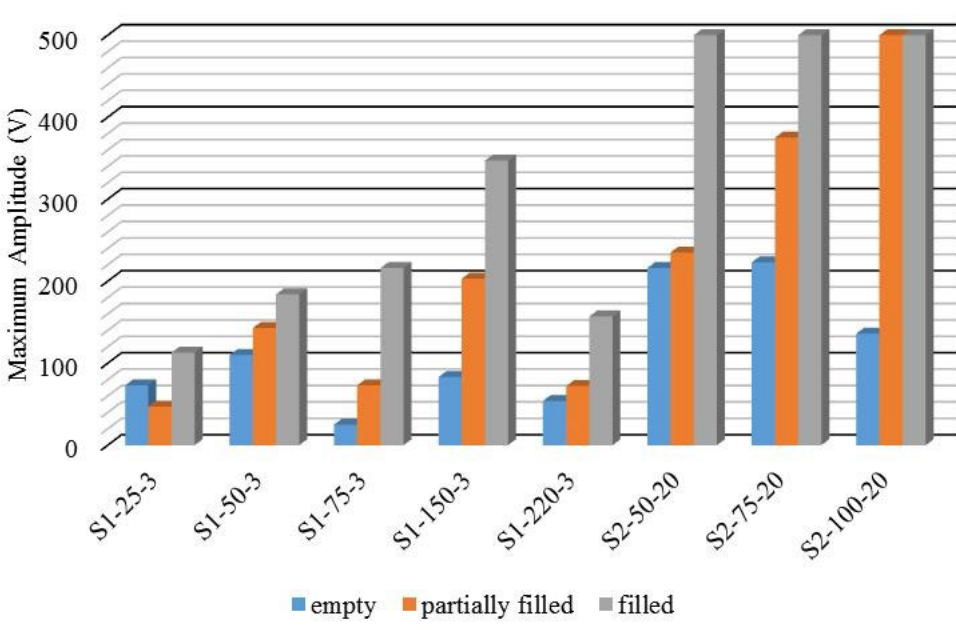
Figure 8. Maximum amplitude